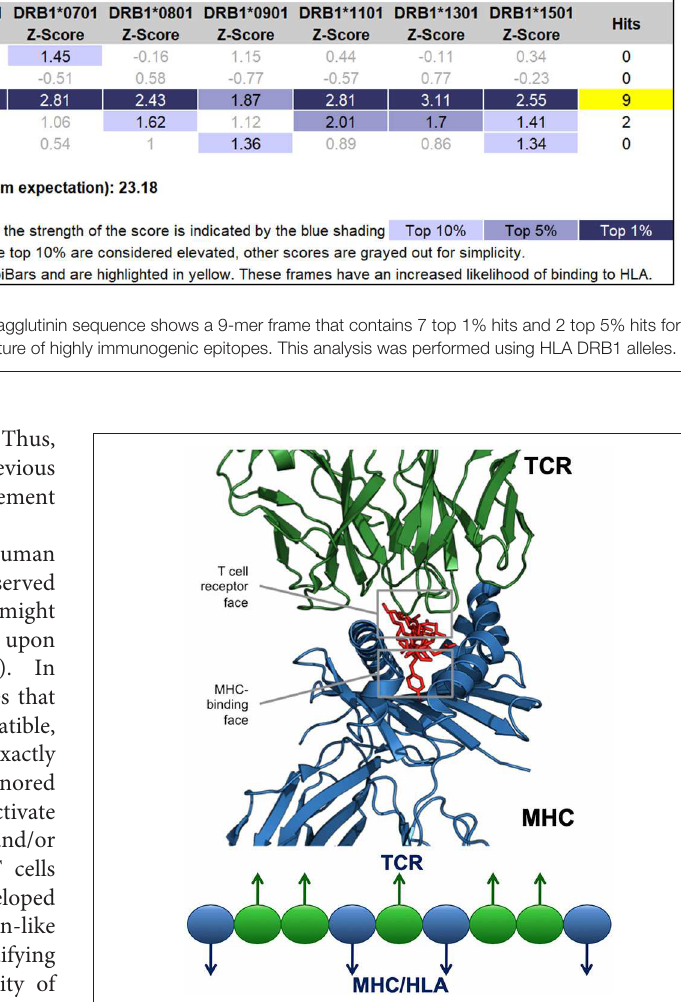
FIGURE 6 | JanusMatrix and self-like epitopes. Each HLA ligand has two faces: the HLA-binding face (agretope, blue residues), and the TCR-interacting face (epitope, green residues). Predicted ligand with identical TCR epitopes and variant HLA-binding agretopes may stimulate cross reactive tolerizing or Treg responses, providing they bind to the same HLA